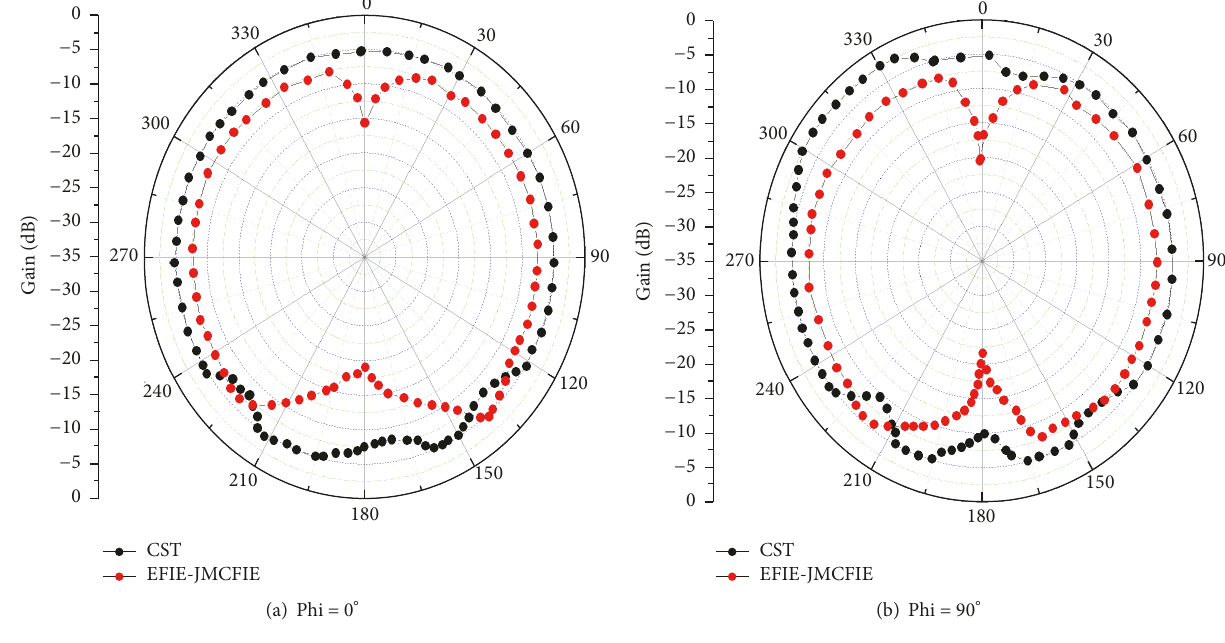
Figure 15: Two-dimensional diagram of pattern pitch surface.